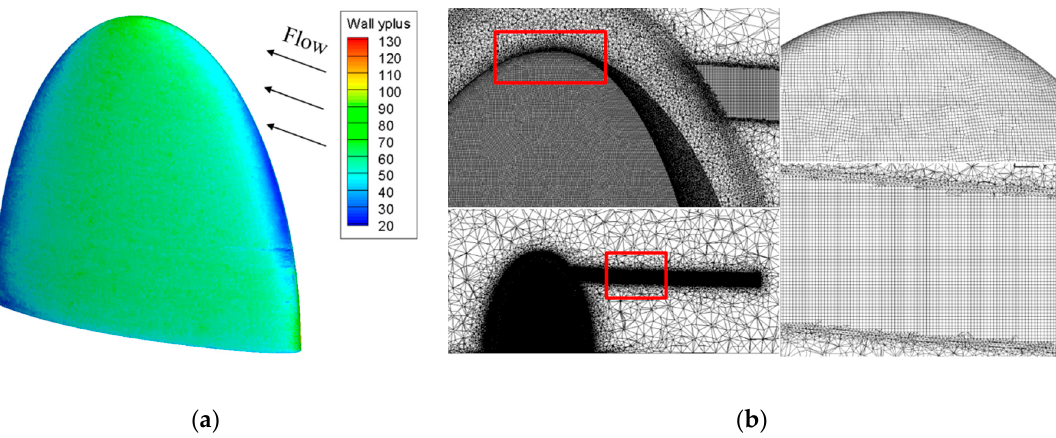
Figure 4. ( a ) Distribution of y + on NACA16-020 wing surface; ( b ) grids in wing near zone and vortex zone. Table 1. Grid refinement in vortex domain.